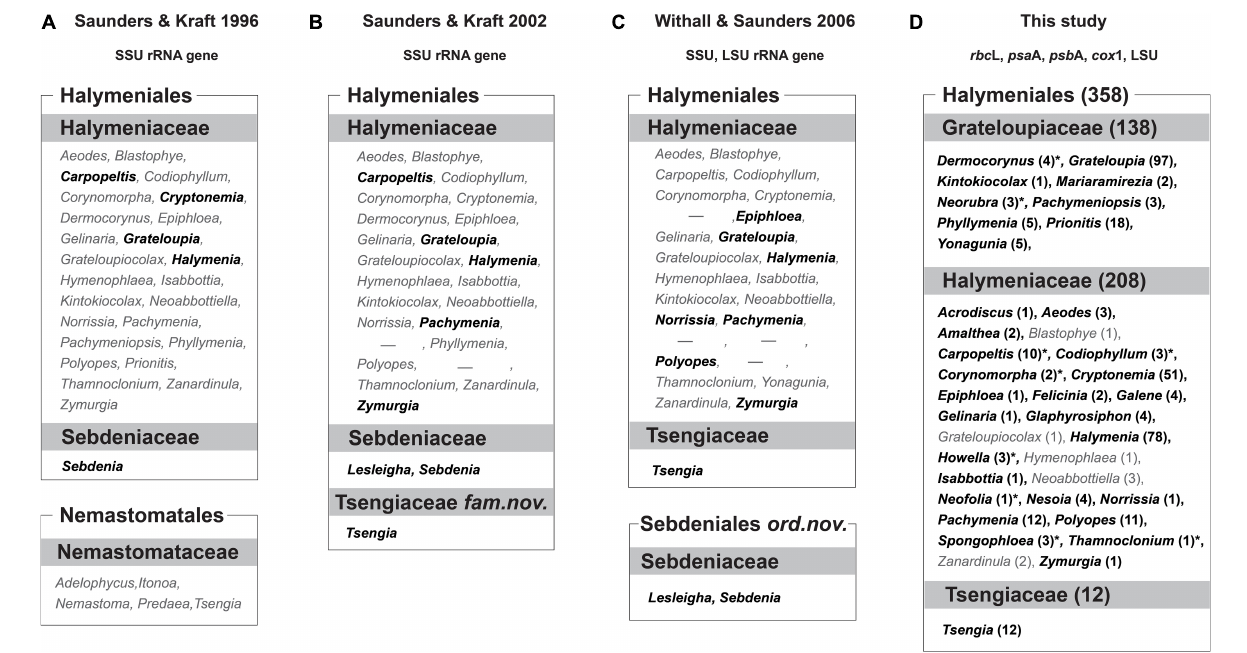
FIGURE 1 | Comparison between current and previous taxonomic concepts of the Halymeniales. (A) Taxonomic concept of Saunders and Kraft (1996). (B) Taxonomic concept of Saunders and Kraft (2002). (C) Taxonomic concept of Withall and Saunders (2006). (D) Taxonomic concept of this study. Bolded black colored genera indicate the taxa analyzed for each study, and gray colored genera indicate the taxa not analyzed for each study. The numbers in parentheses indicate the number of species in each genus. Asterisk (*) indicates analyzed taxa for rbc L only. Dash (-) indicates the genera that have been synonymized with the genus Grateloupia but recently